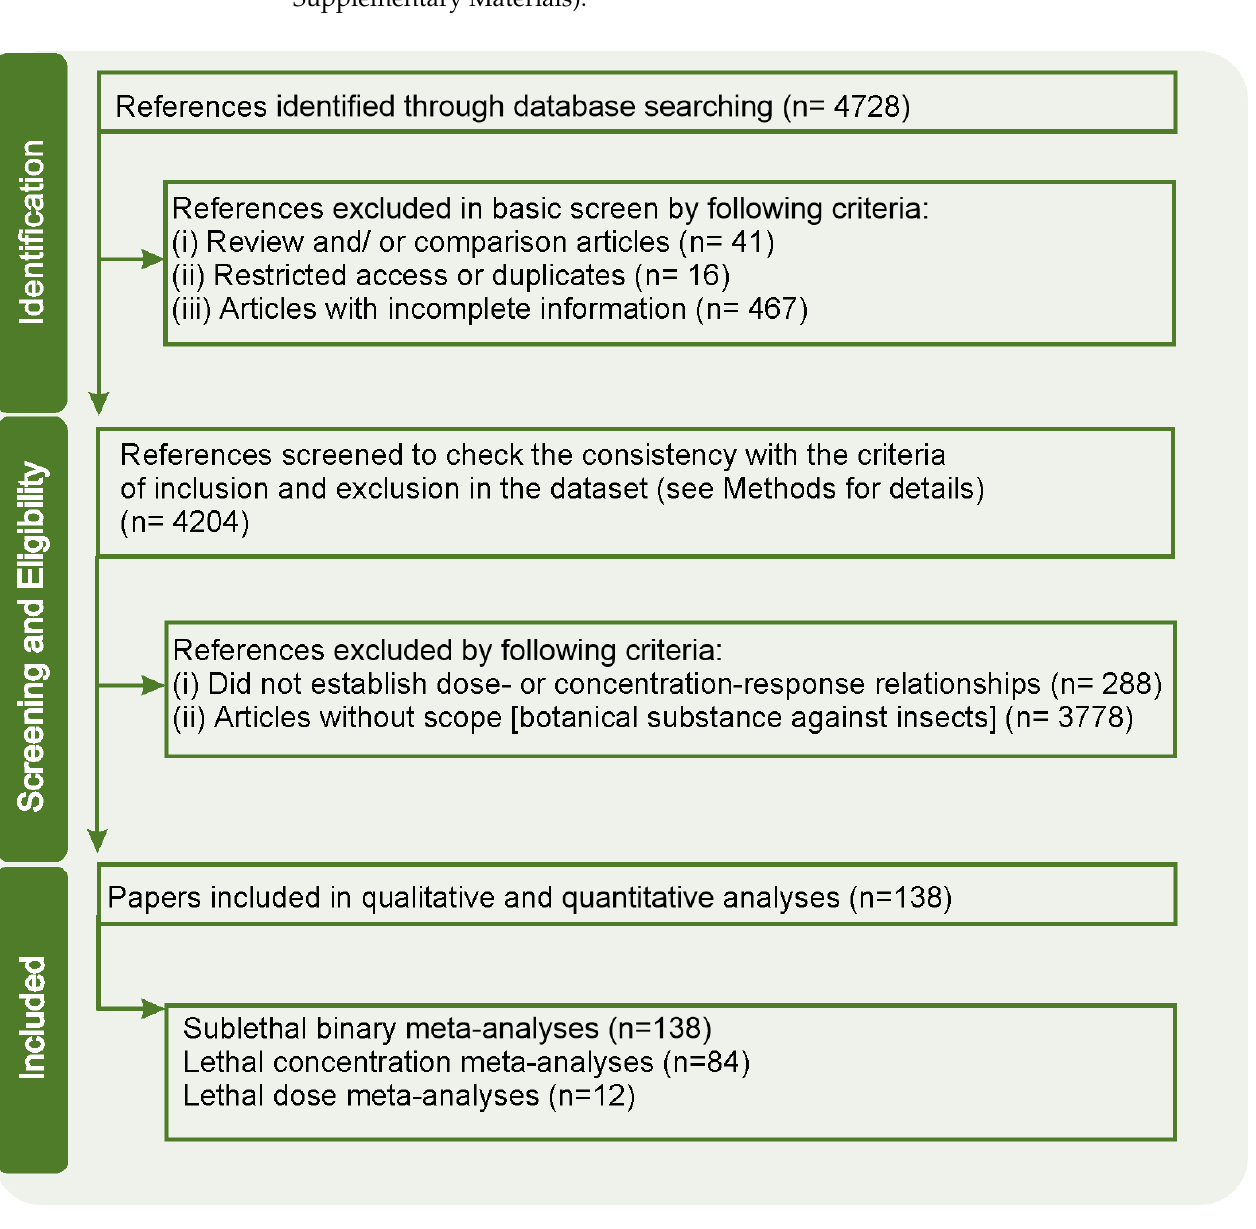
Figure 1. Flowchart diagram describing the steps of filtering data from scientific papers obtained from the systematic literature survey review that used the Web of Science database (1945–April 2021).